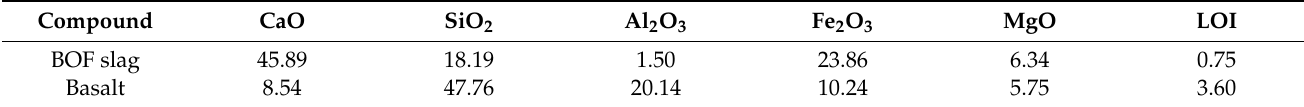
Table 1. Chemical composition of basic oxygen furnace (BOF) slag and basalt (%).